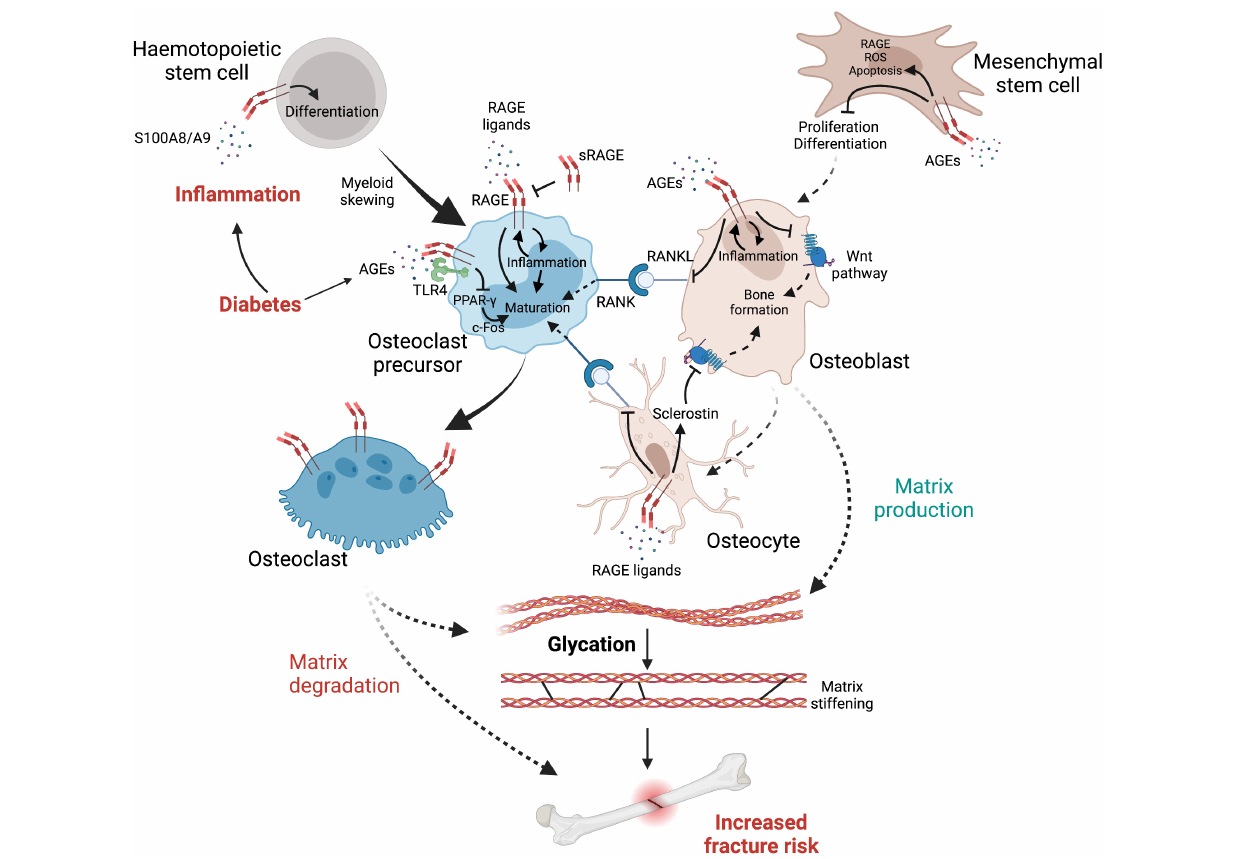
FIGURE 3 | The complex interplay between cells, inflammatory factors, AGEs and RAGE leading to elevated fracture risk in diabetes. Diabetes reduces osteoblast production while promoting myeloid skewing from hematopoietic stem cells, notably via RAGE signaling, favoring the production of osteoclast precursors. RAGE initiates a self-sustaining pro-inflammatory response which promotes differentiation of osteoclast precursors into fully mature osteoclasts that express high levels of RAGE. Osteoclast differentiation is further facilitated by RANKL up-regulation, initiating osteoclast maturation signals when interacting with RANK, which is promoted by RAGE signaling from osteocytes and osteoblasts. However (see text for details), AGEs can also negatively affect osteoclast maturation via RAGE-independent mechanisms. In contrast, the Wnt pathway is inhibited either directly by RAGE signaling or by its upregulation of sclerostin produced by osteocytes, therefore provoking an imbalance in favor of bone matrix degradation. Glycation of the organic matrix itself leads to structural changes such as matrix stiffening, increasing brittle fracture risks and impairing bone